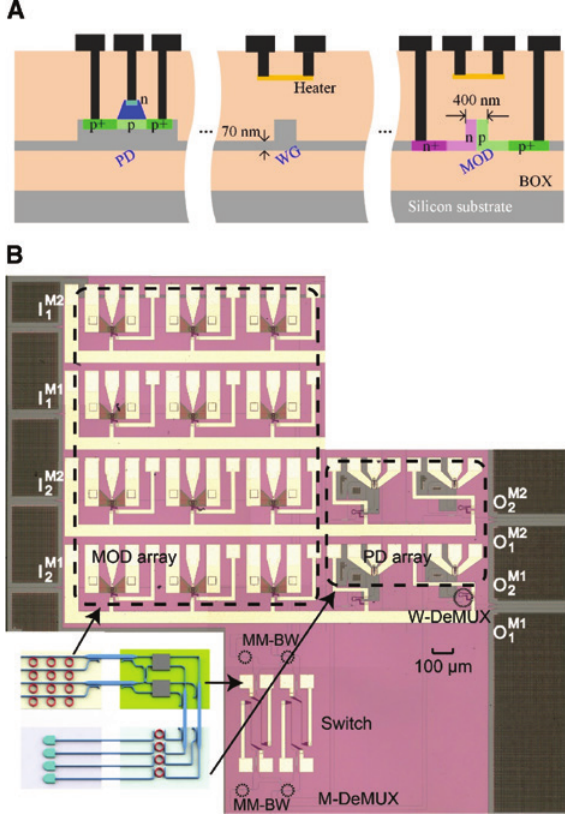
Figure 3: Physical structure of the device. (A) Schematic of the sectional view. (B) Micrograph of the fabricated device. AD-MRR, add-drop microring resonator; MM-BW, multimode bus waveguide; MOD, modulator; MUX, multiplexer; PD, photodetector.